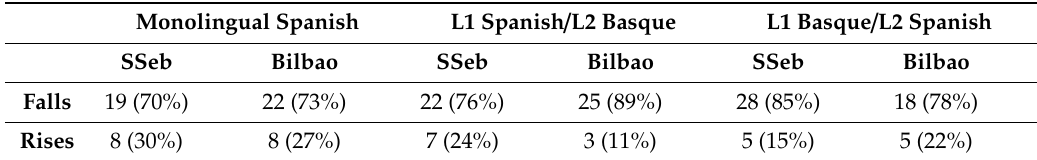
Table 1. Numbers and percentages of information-seeking yes / no interrogatives with rising–falling and rising final contours (Falls and Rises, respectively) for each linguistic profile in San Sebastian and